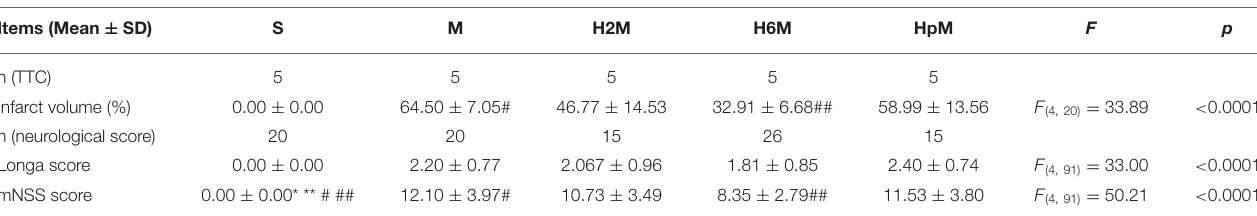
TABLE 1 | Damage evaluation in rats after